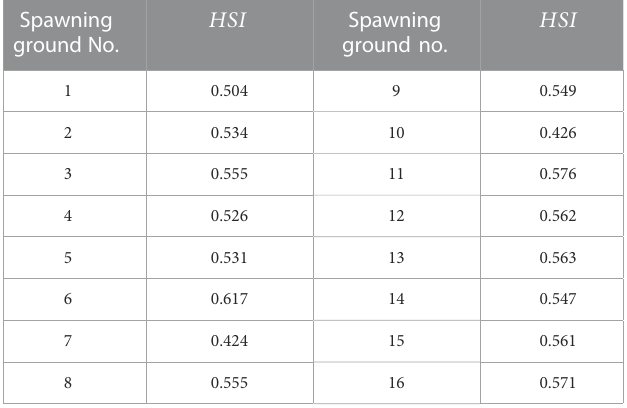
TABLE 3 HSI values of the spawning grounds of the Yellow River carp from April 1 to 30 June 2014. Spawning ground No.